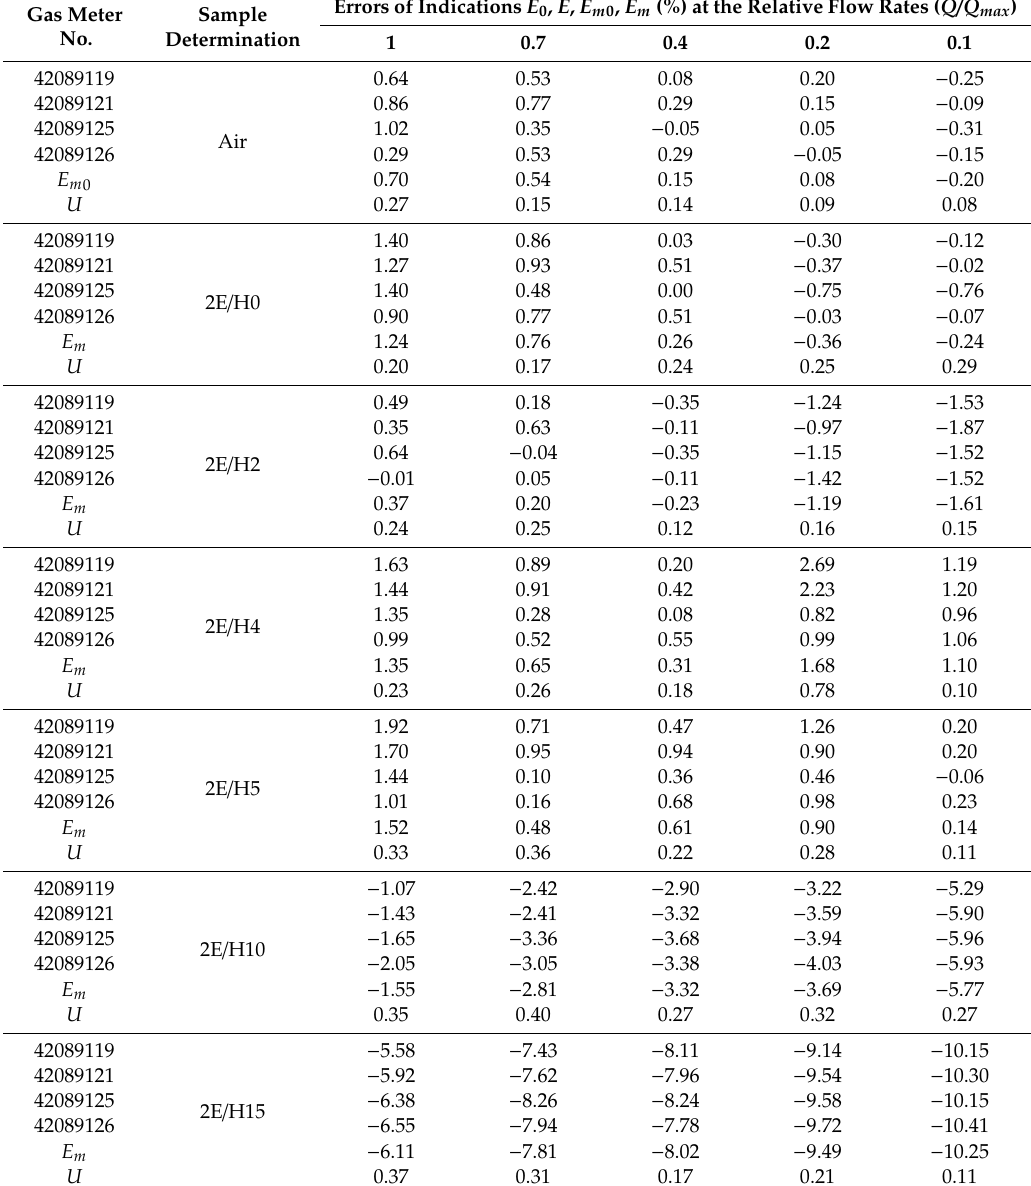
Table 3. The errors of indications ( E 0 , E ), the average errors of indications ( E m 0 , E m ) with the confidence interval ( u ) of the thermal gas meters for gas mixtures and the relative flow rates ( Q / Q max ). Gas Meter